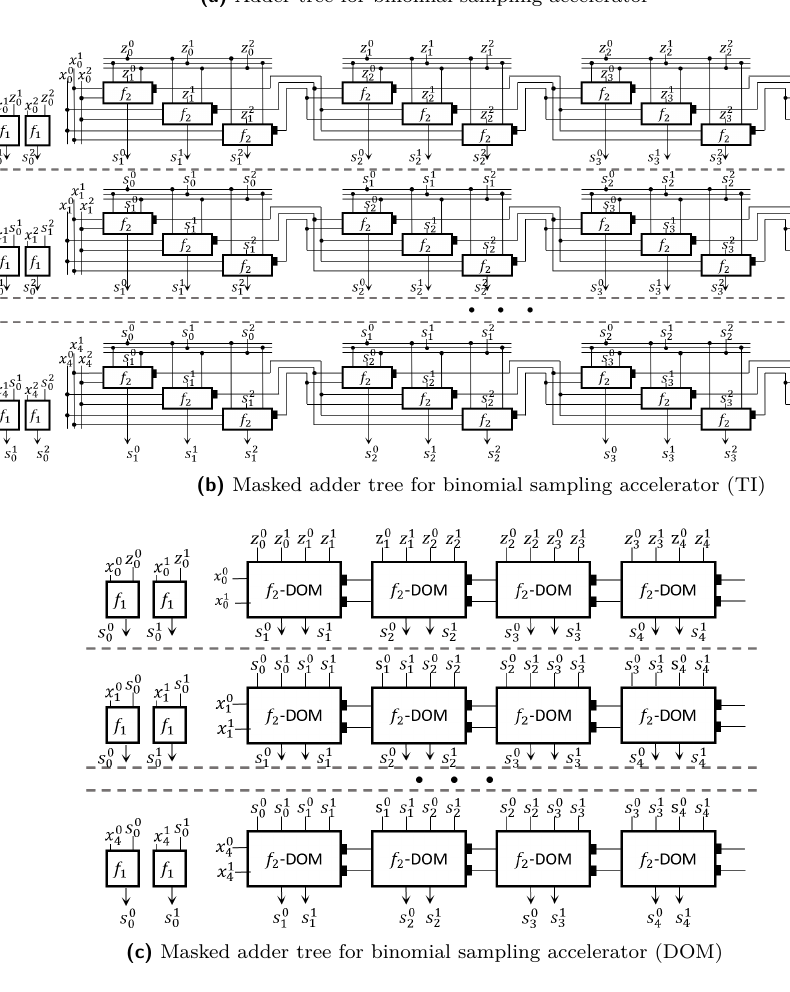
Figure 10: Adder tree for binomial sampling (Binom Tree) with η max =